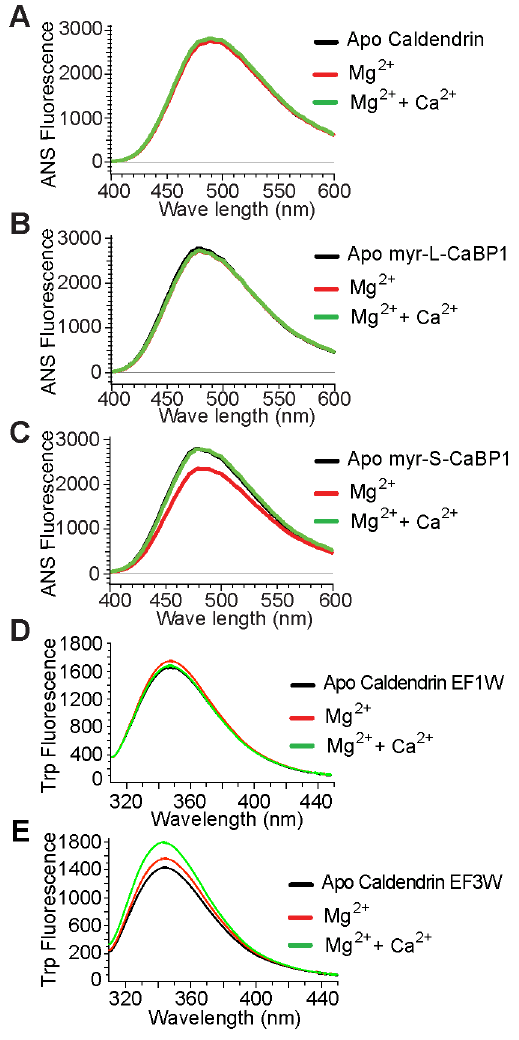
Figure 2. Extrinsic fluorescence ANS (1-Anilino-8-Naphthalin Sulfonate) fluorescence spectroscopy of Caldendrin and L- and S-CaBP1. (A) Mg 2 + and Ca 2 + titration to Mg 2 + bound apo Caldendrin shows no change in the fluorescence intensity. (B) Titration of Mg 2 + and Ca 2 + titration to Mg 2 + bound L-CaBP1 shows no change in the fluorescence intensity. (C) Effect of Mg 2 + and Ca 2 + on apo S-CaBP1. Titration with Mg 2 + results in a significant decrease in the fluorescence intensity, whereas Ca 2 + titration to Mg 2 + bound S-CaBP1 reversed this effect. (D) Titration with Mg 2 + affects tryptophane fluorescence intensity in EF1W mutant Caldendrin, (E) EF3W mutant Caldendrin exhibits large changes in tryptophane fluorescence intensity following Mg 2 + and Ca 2 + titration. For all titrations a protein concentration of 1 m M was used. The Mg 2 + concentration was 0.5 mM and the Ca 2 + concentration was 50 m